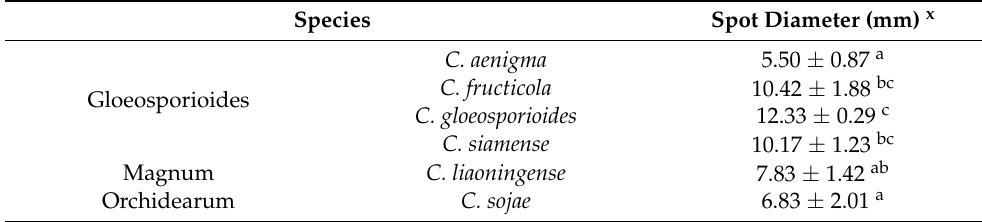
Table 4. Pathogenicity of different strains inoculated on walnut leaves after 4 days.